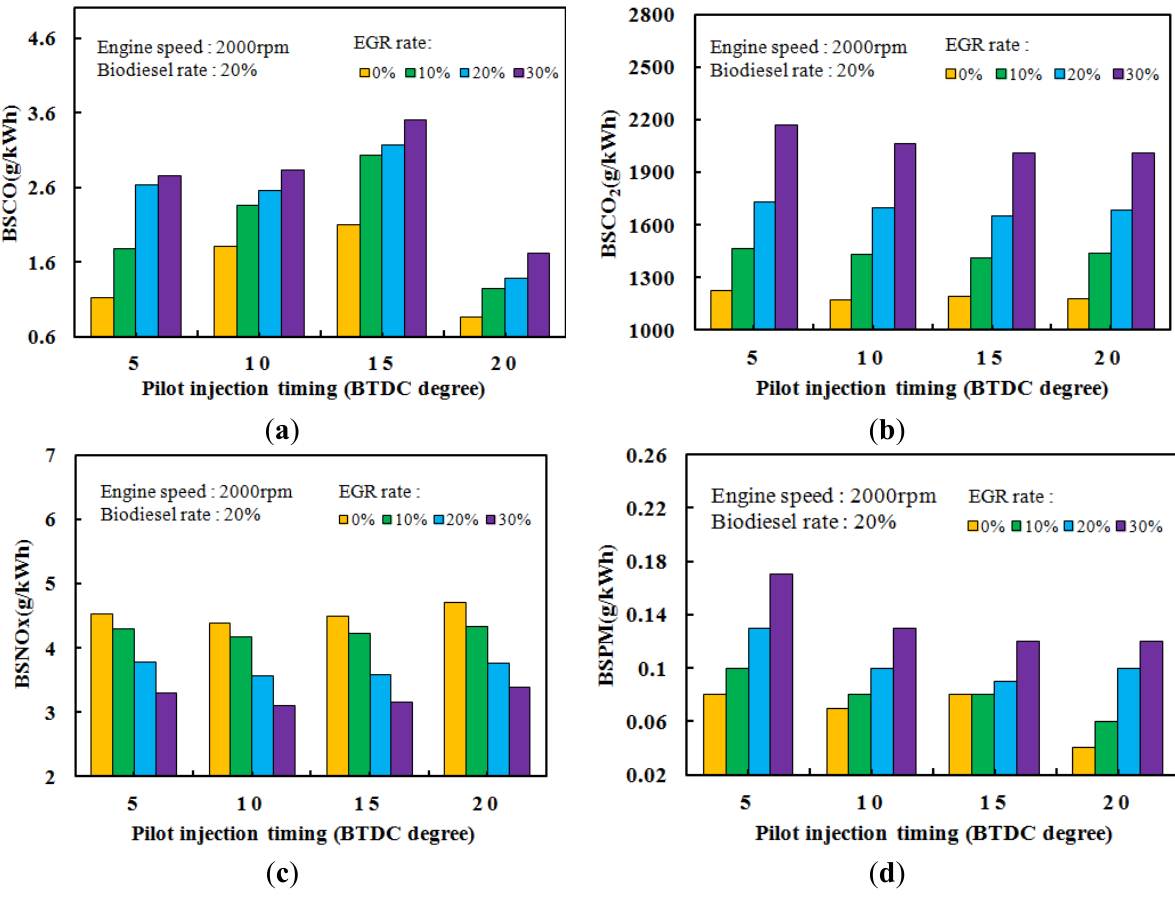
Figure 8. Effects of various pilot injection timings and EGR rates on the ( a ) BSCO; ( b ) BSCO 2 ; ( c ) BSNO x ; and ( d ) BSPM